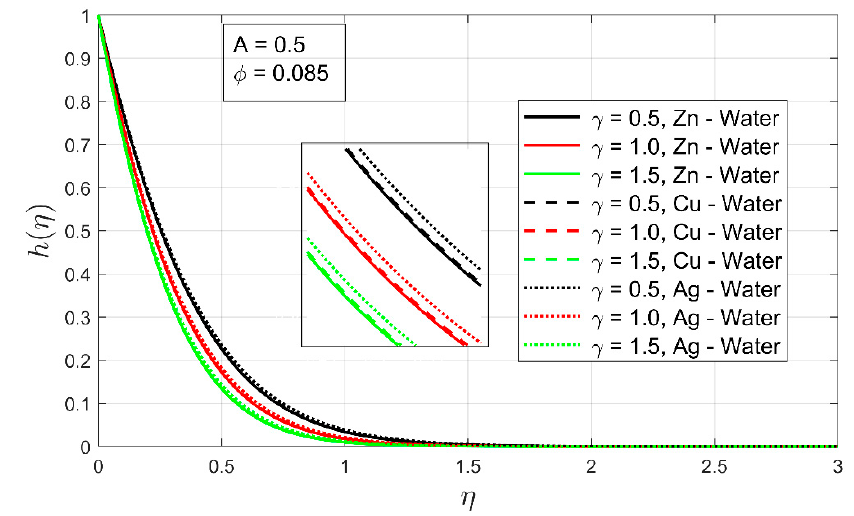
Figure 10. The temperature profile h ( η ) as a function of stretching ratio parameter γ